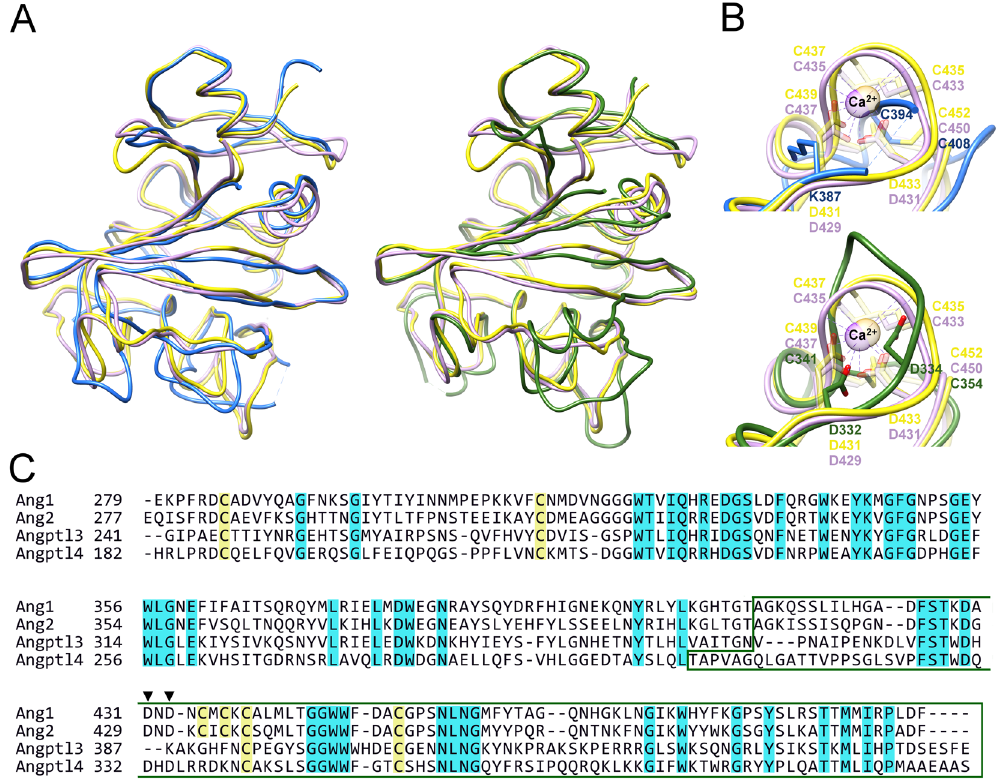
Figure 2. Comparison of the Angptl3 and Angptl4 fibrinogen-like domains with angiopoietins. ( A ) Overlay of the C α -trace of Angptl3 (blue, left) and Angptl4 (green, right) with those of Ang1 (yellow) and Ang2 (violet). ( B ) Comparison with Ca 2 + binding site of Ang1 (light yellow) and Ang2 (light violet) of the equivalent region in Angptl3 (blue, top) and Angptl4 (green, bottom). Residues involved in Ca 2 + binding are shown in stick representation and colored similarly to the protein they belong. Ca 2 + ions are shown in ball representation. ( C ) Alignment of the proteins shown in panel A. Cysteines are highlighted in yellow and conserved amino acids in blue. The P subdomain is boxed and the Asp involved in calcium binding in Ang1 and Ang2 are indicated with